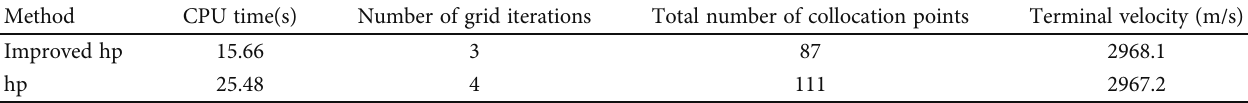
Table 2: Comparison of mesh re fi nement results.